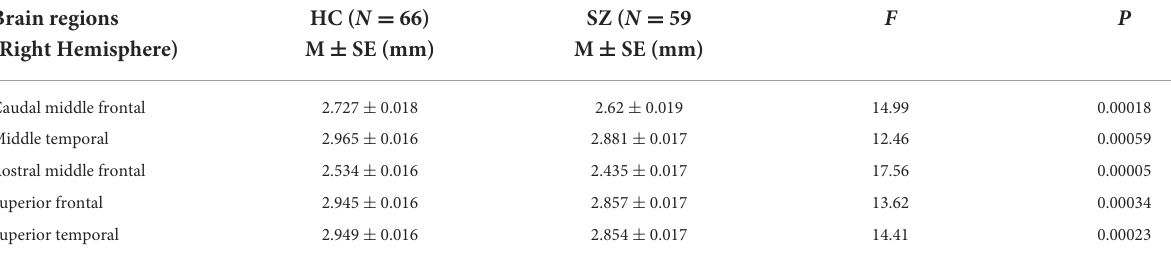
TABLE 2 Significant group differences between SCZ and HC on cortical